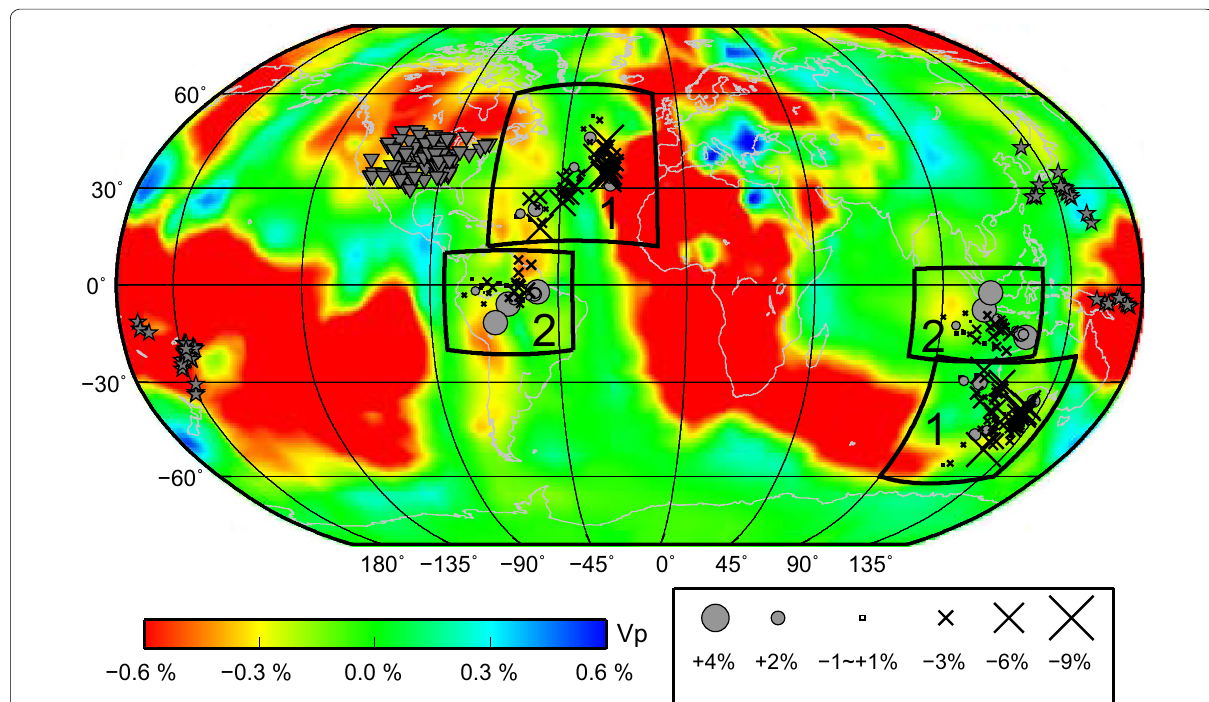
Fig. 7 P-wave velocity variations plotted at the middle points of diffracted paths of PKKP ab in two regions (marked by box 1 and 2 ) at the CMB. Slow and fast are shown using black crosses and gray circles , respectively. The background is the P -wave tomographic model at the CMB from GyPSuM (Simmons et al. 2010). The gray stars denote the earthquakes, and the gray inverted triangles denote the stations